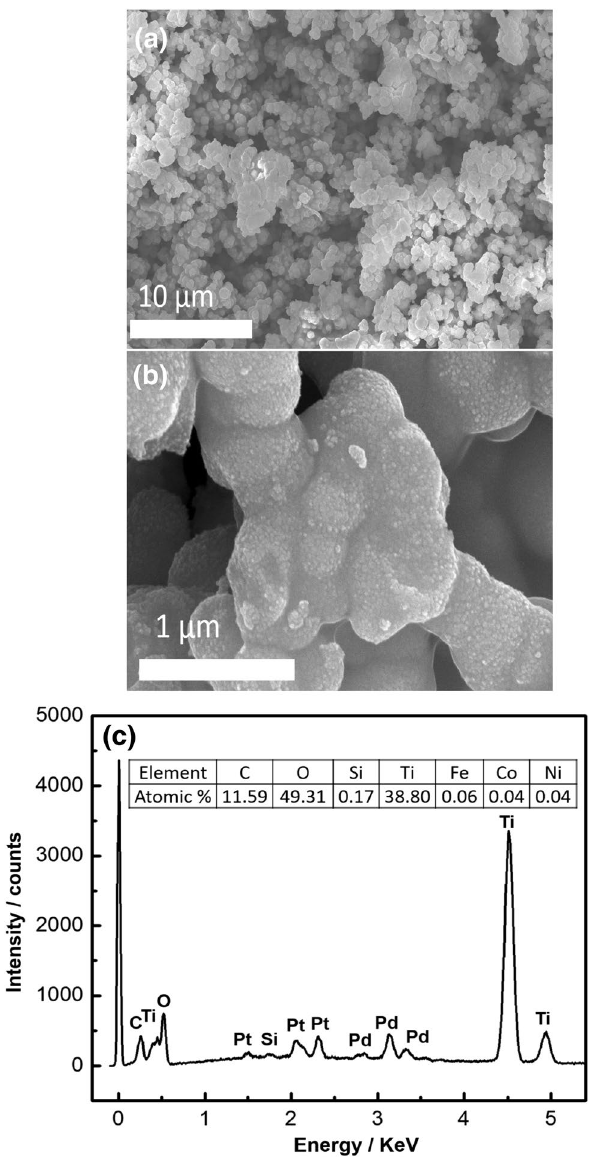
Figure 6. ( a ) SEM image of the prepared Co x Ni 1−x Fe 2 O 4 ; x = 0.9/SiO 2 /TiO 2 /C-dots nanocomposite; ( b ) Magnified SEM image; ( c ) EDX pattern with elemental